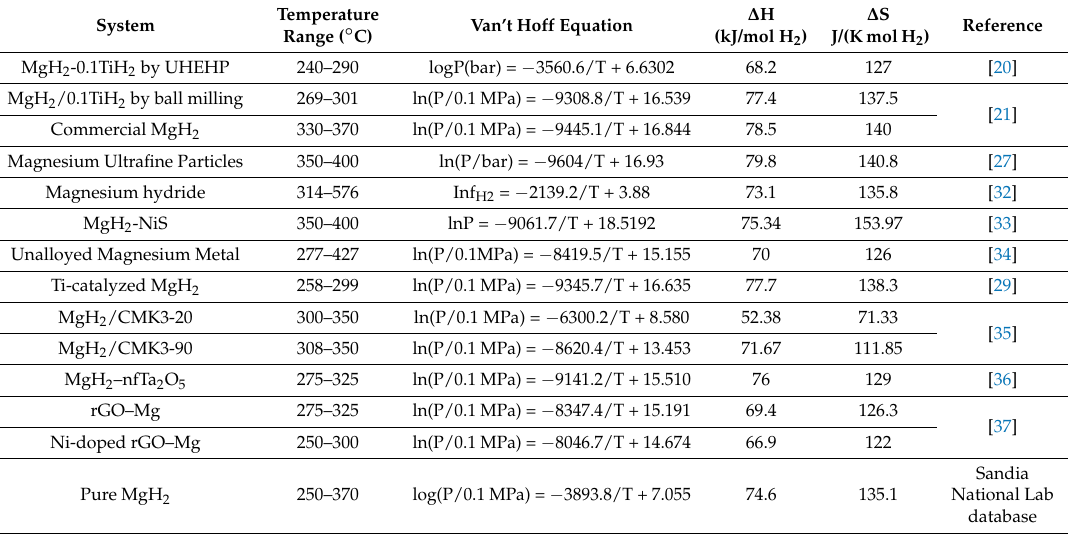
Table 1. The temperature range, van’t Hoff equations, enthalpy and entropy change values of different Mg-based